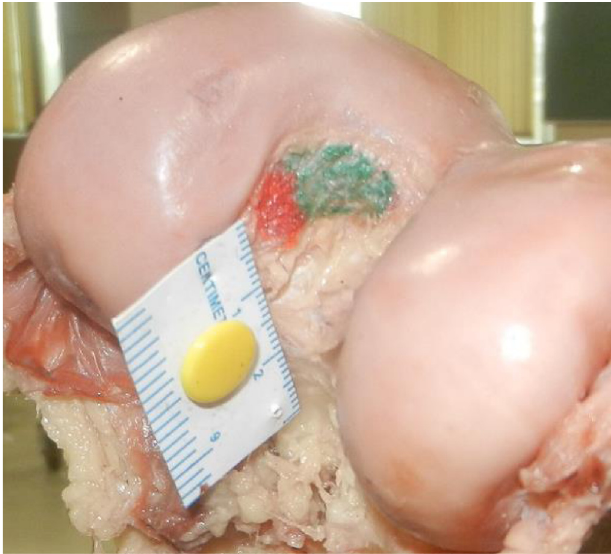
Figure 4. Footprint of PCL on femur before bone resection. Antero-lateral bundle is marked with green and postero-medial bundle with red.